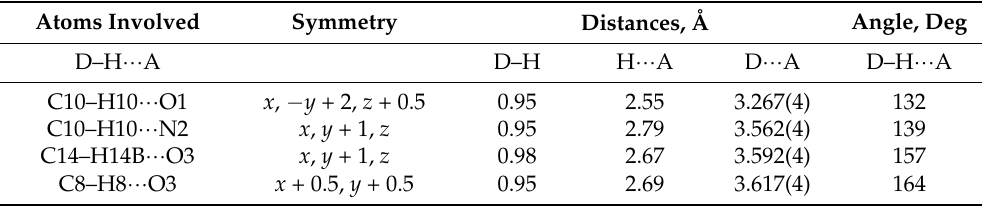
Table 2. Geometry of hydrogen bonds in the structure of 4